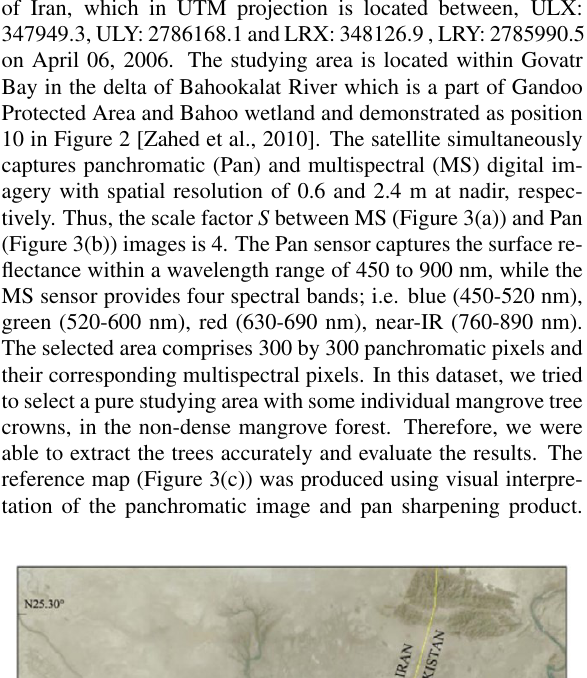
Figure 3: (a) Three-band colour composite of QuickBird Image. (b) The panchromatic image of QuickBird Image. (c) Reference data of the mangrove forest dataset. (d) Generated SR map using spatially adaptive MRF-SPM